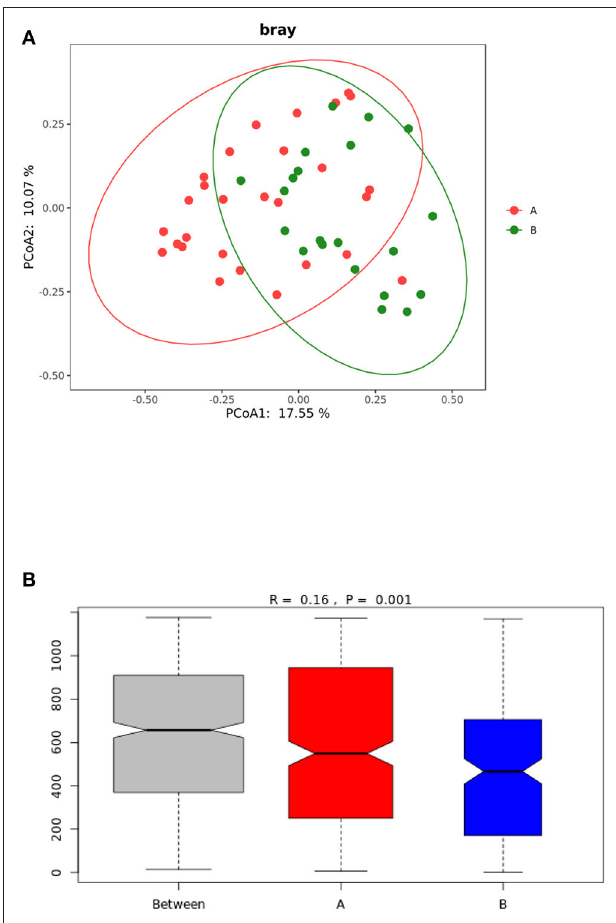
FIGURE 2 | (A) PCoA analysis of gut microbiota in TD group and control group. (B) ANOSIM analysis of gut microbiota in the TD and control groups. Group A: TD group; Group B: control